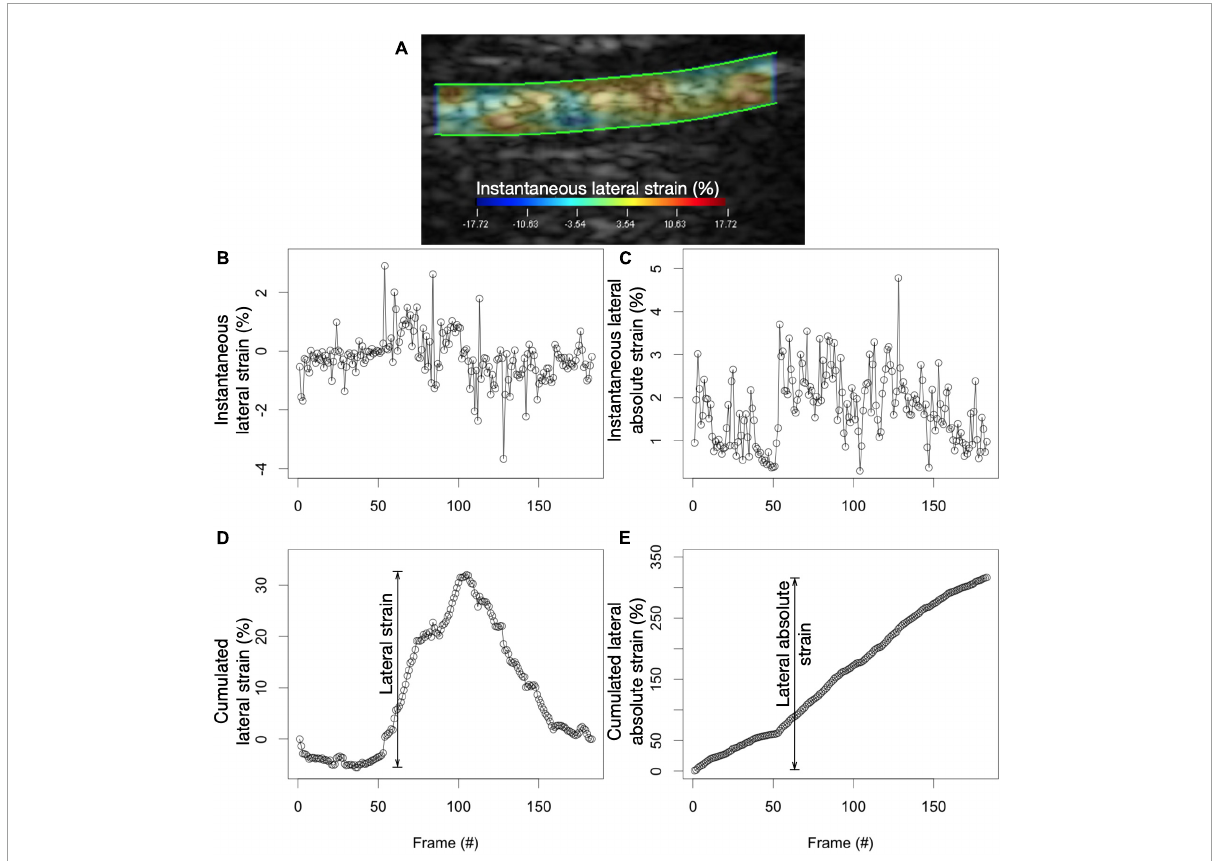
FIGURE1 Calculating lateral strain and lateral absolute strain values. (A) Instantaneous strain values are computed in all sub-ROIs between consecutive frames of a cineloop. (B) By averaging all instantaneous sub-ROI strain values in a single frame, instantaneous strain values for the whole ROI are plotted for all frames of the cineloop. (C) The summation of instantaneous strain values produces the cumulative strain of the pleura. Lateral strain is the range of the cumulative lateral strain experienced by the lung in the ROI. (D) On the other hand, by averaging all absolute sub-ROI instantaneous strain values in a single frame, instantaneous absolute strain values for the whole ROI are plotted for all frames of the cineloop. (E) The summation of the instantaneous absolute strain values produces the cumulative absolute strain of the pleura. Lateral absolute strain is the range of the cumulative lateral absolute strain experienced by the lung in the